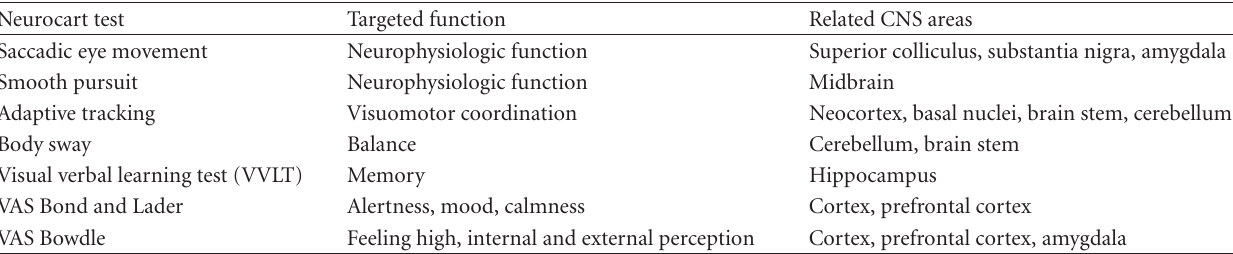
Table 2: Component tests of the Neurocart battery and the related CNS